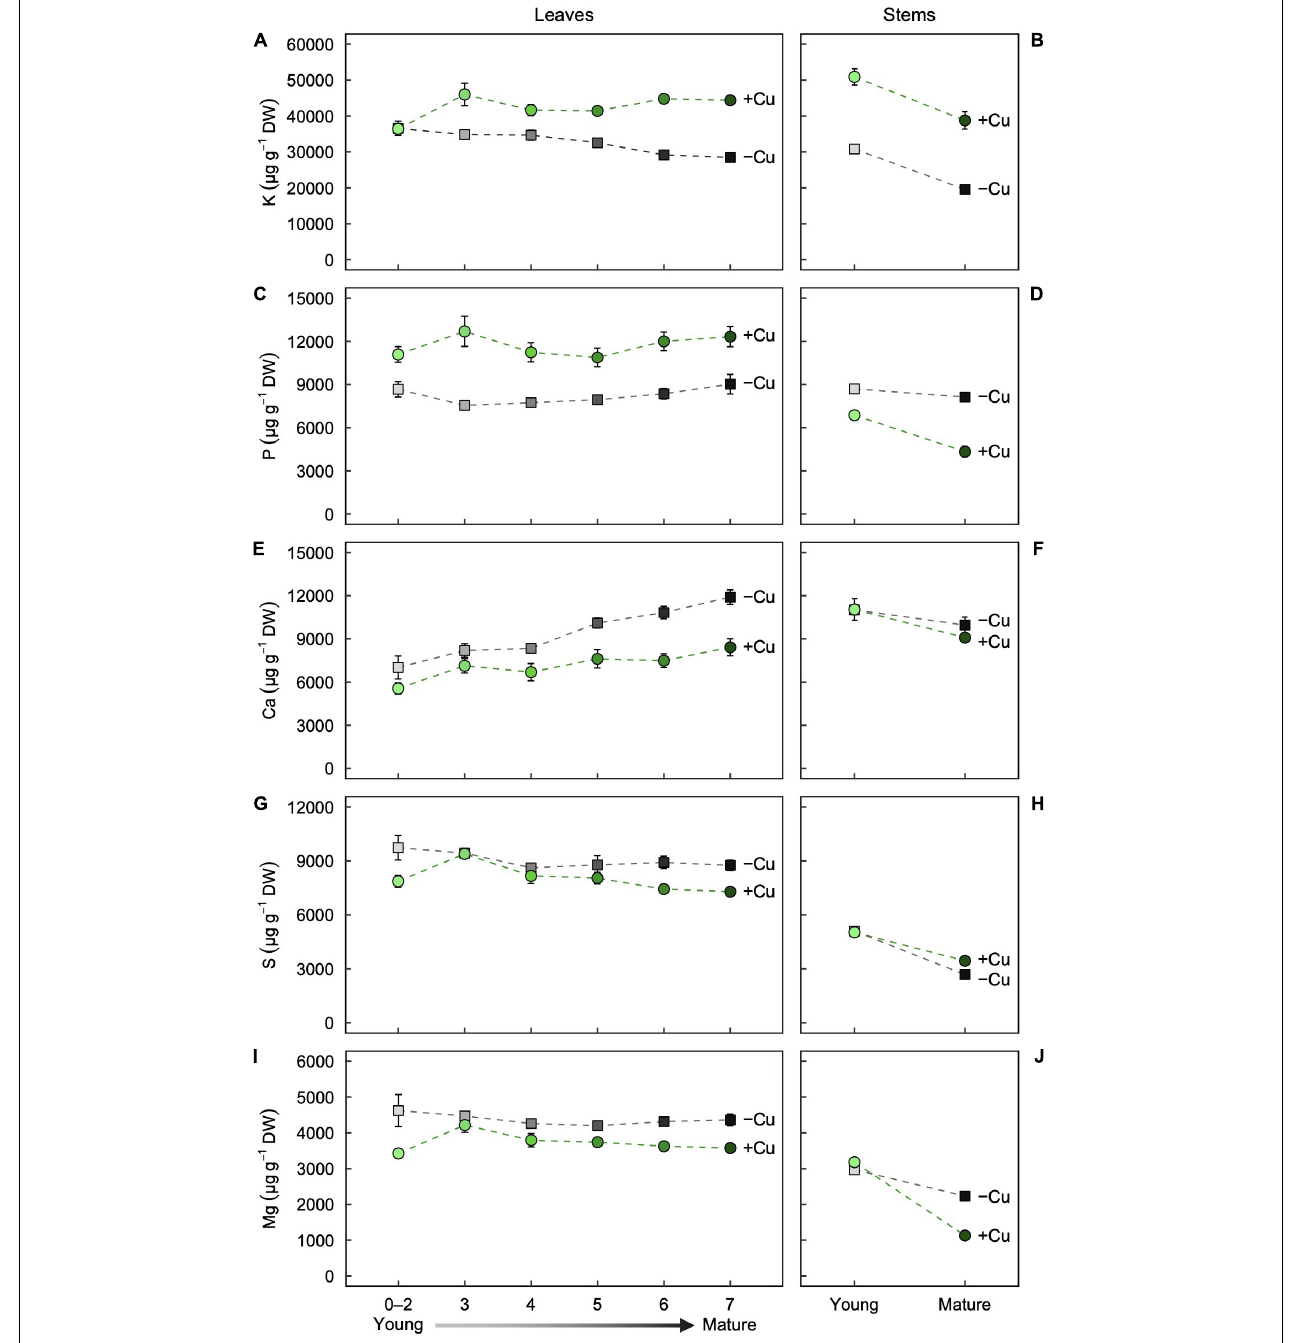
FIGURE 2 | Partitioning of the macronutrients (A,B) K, (C,D) P, (E,F) Ca, (G,H) S, and (I,J) Mg as a function of age in (A,C,E,G,I) leaves and (B,D,F,H,J) stems of hybrid white poplar ( P. tremula × P. alba ) grown in +Cu (green circles) and –Cu (gray squares) conditions. Mean values ± SE ( n = 6). Results of two-way ANOVAs for the effects and interaction of tissue age and Cu feeding status on mineral partitioning in leaves as well as stems are shown in Table 1